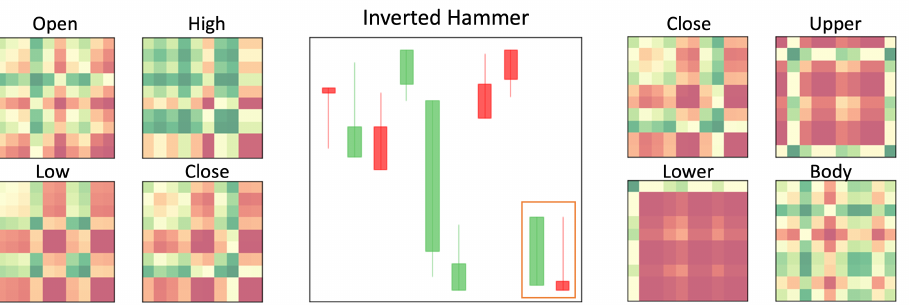
Figure 17. Example of Inverted Hammer pattern and GASFs. The middlemost figure is the original candlesticks. The red and green candlesticks represent closing prices are higher than the opening prices are not. The left and right sides are the heatmaps of GASFs. The range of the heatmap is ( − 1,1 ) , where red equals − 1 and green equals 1.